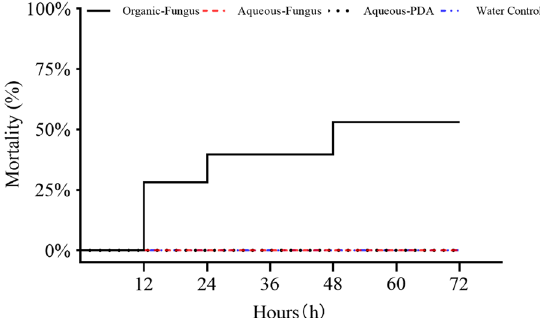
Fig. 4 Toxicity of the wz‑1 metabolites against Diaphorina citri . Trend over time in the percentage mortality of D. citri adults with hours